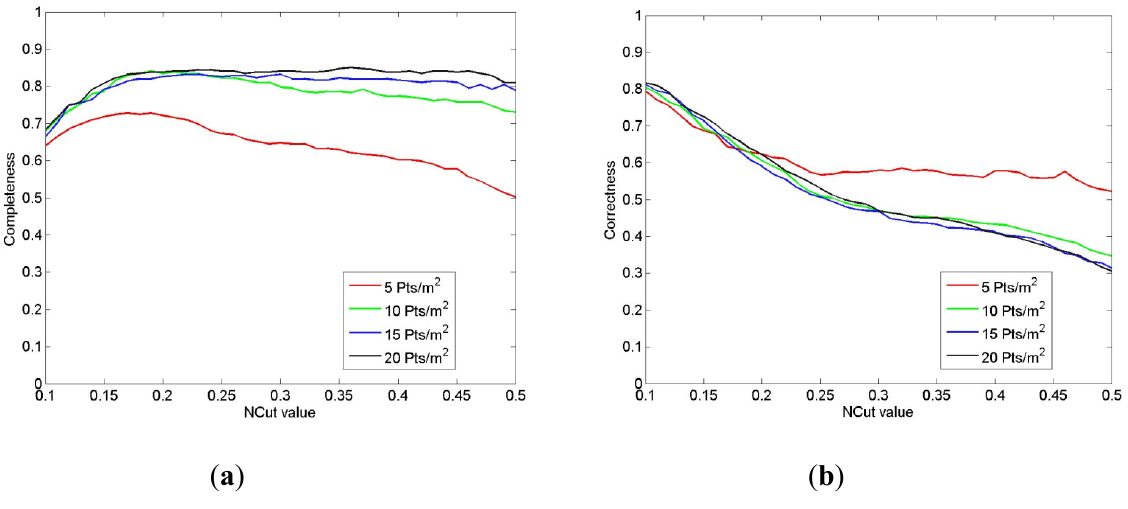
Site II acquired under leaf-off condition; ( a ) Completeness; ( b ) Correctness; colored lines indicate different point densities.